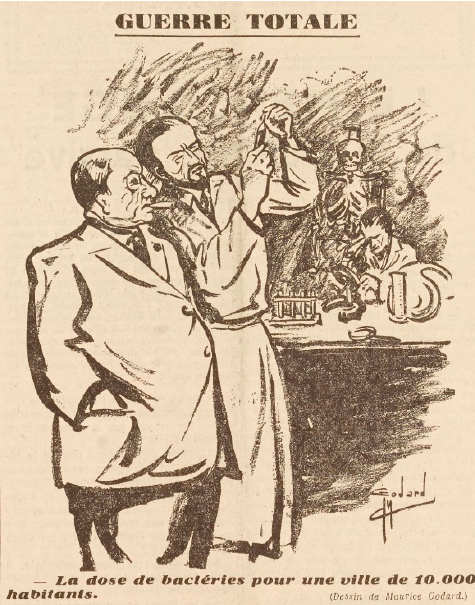
Figure 13. “Total War. The dose of bacteria for a village of 10,000 inhabitants.” La Patrie Humaine. June 17, 1938. Ink on Paper. Bibliothèque Nationale de France.